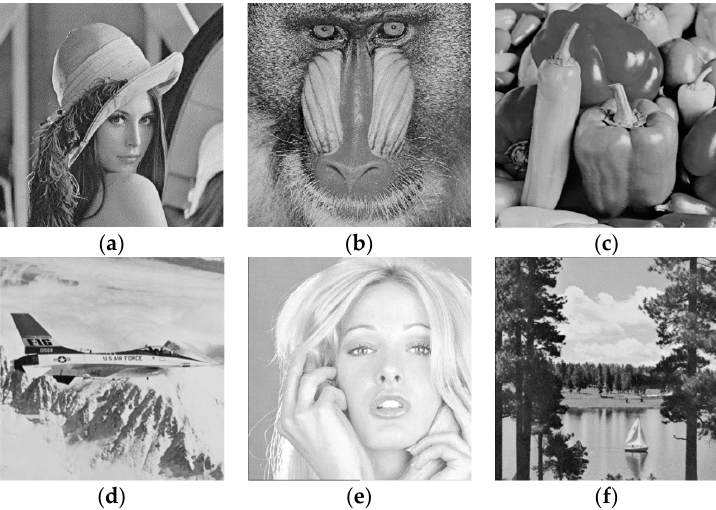
Figure 6. Six 512 × 512 test images. ( a ) Lena, ( b ) Baboon, ( c ) Peppers, ( d ) Airplane, ( e ) Tiffany, ( f ) Lake.